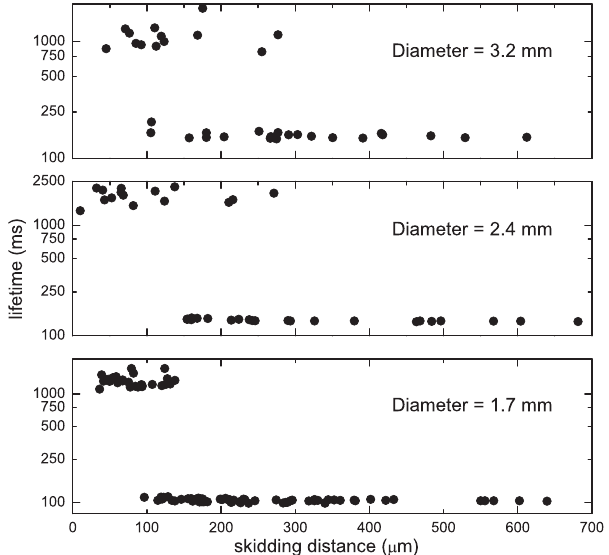
FIG. 17. Droplet lifetime versus skidding distance for various droplet diameters. All droplets have the same viscosity (50 cSt) and similar impact velocities (0.36, 0.33, and 0 . 32 m = s from top to bottom), with only the diameter significantly varied from 3.2 to 1.7 mm (from top to bottom). Similar results are obtained as in Fig. 1: there always exist two distinct states with long and short lifetimes.